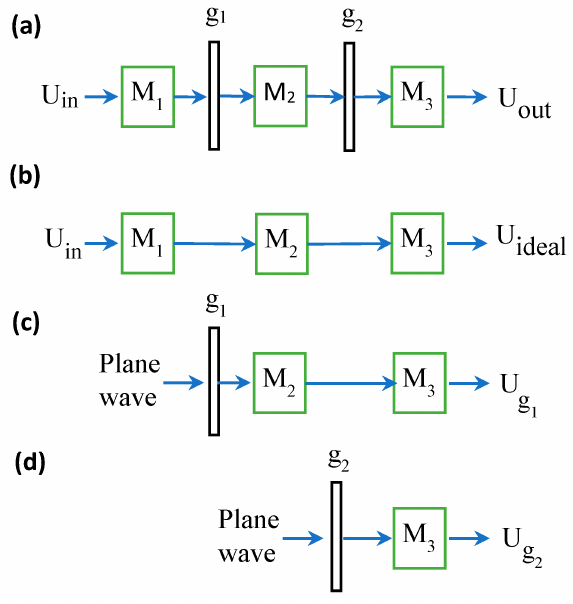
Figure 2. ( a ) General scheme of paraxial optical system with arbitrary general masks (not necessarily RPSs) at arbitrary positions. M 1 , M 2 , M 3 denote the sub-systems of the paraxial system before, between, and after the masks g 1 and g 2 . ( b ) The maskless ideal core system. ( c , d ) are the projection systems of g 1 and g 2 .,